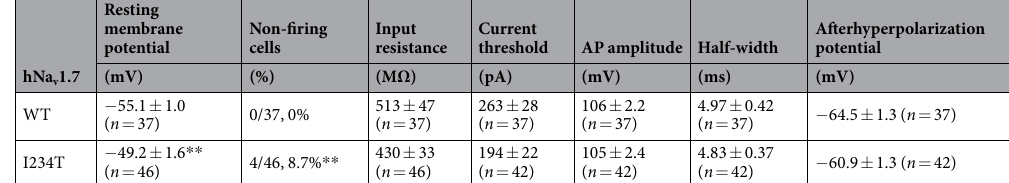
Table 1. Current-clamp characteristics of DRG neurons expressing WT or I234T Na v 1.7 measured at native resting potentials. ** Indicates p <